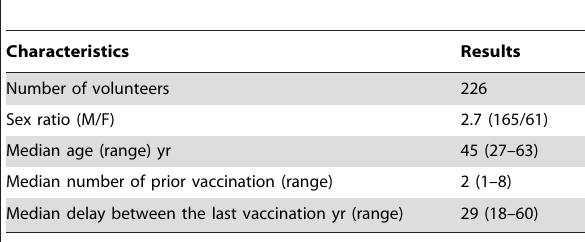
Table 2. Characteristics of the volunteers before revaccination.